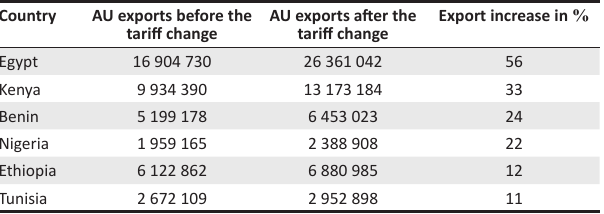
TABLE 1: Increase in African Union export to South Africa after the Free Trade Area (US$). Country